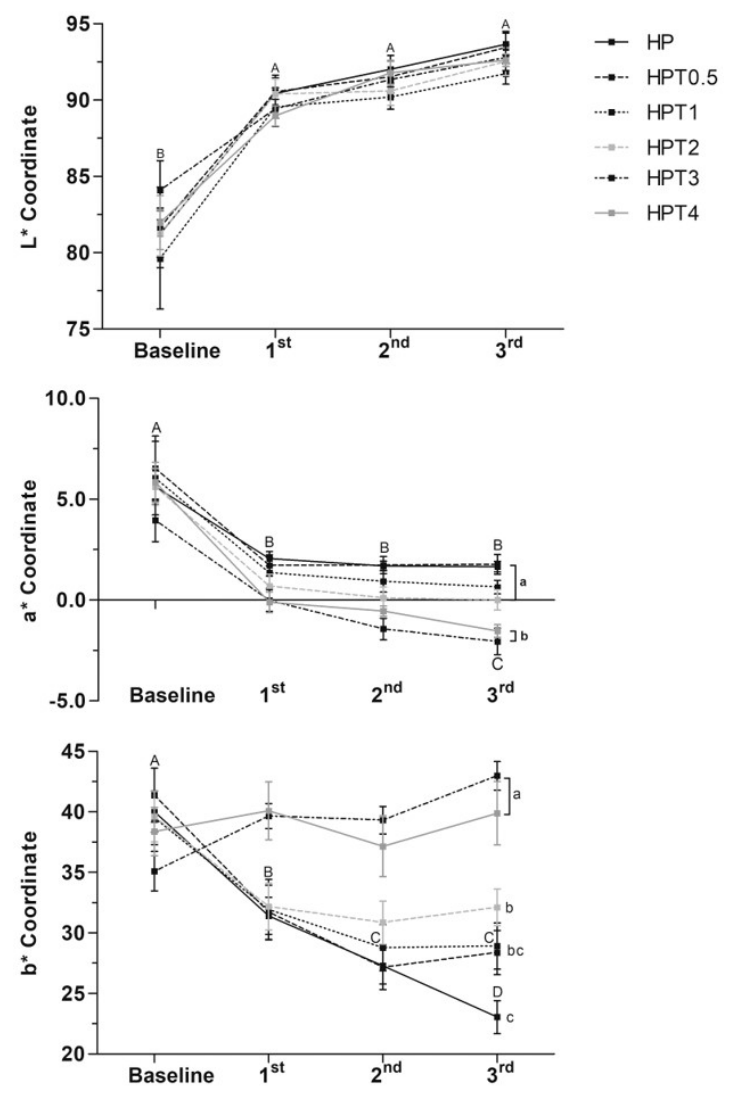
Figure 1. CIEL*a*b* coordinates of different bleaching treatment over time application. Legend: Means and standard deviation followed by different letters indicate statistical differences according to two- way repeated measures, ANOVA and Bonferroni test, with significant level set at 5%. Uppercase letters compare color parameters over time within bleaching agents. Lowercase letters compare bleaching treatment groups. N = 10 specimens/group. HP: hydrogen peroxide; T: titanium